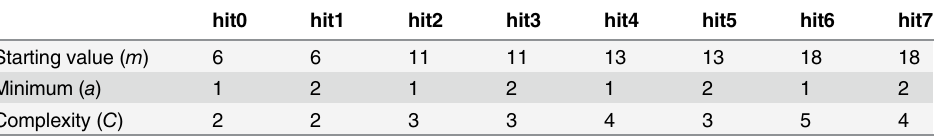
Table 2. The hit games